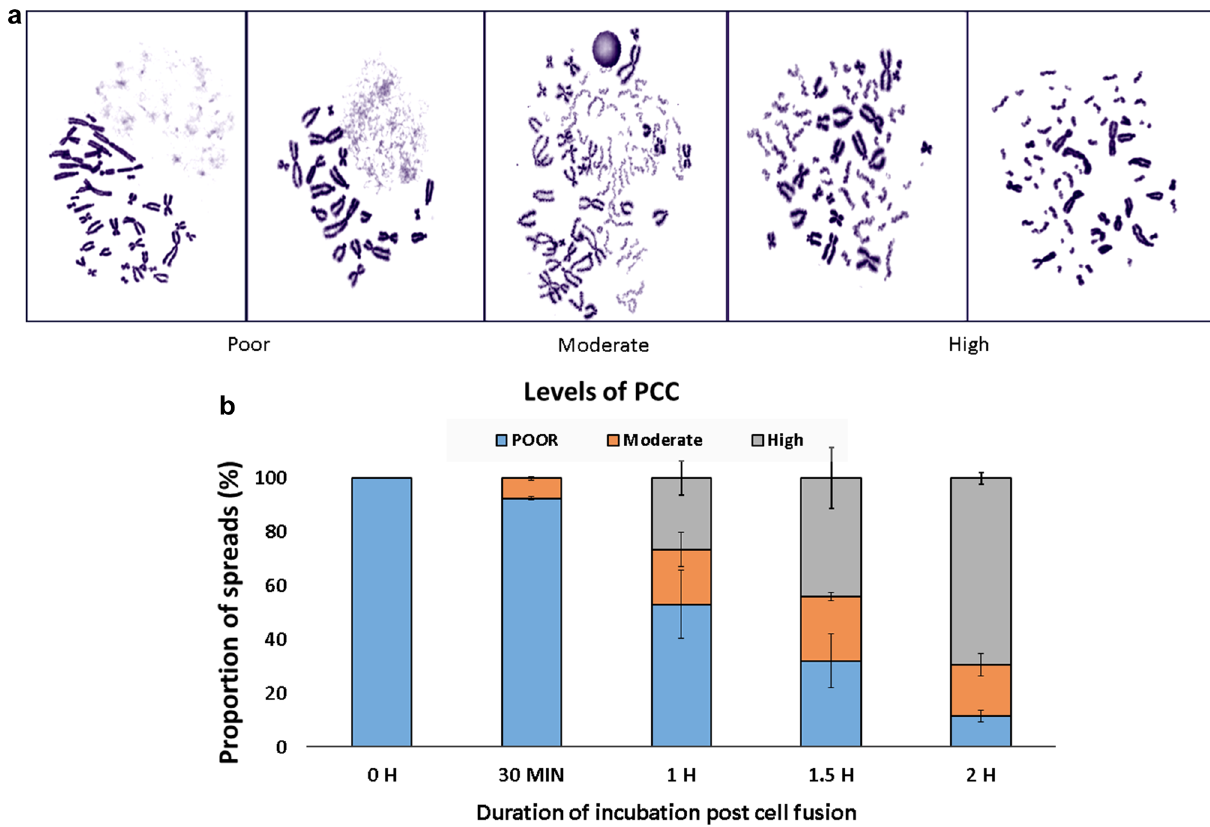
Figure 5. ( a ) Levels of chromosome condensation in PCC from 0 to 2 h after cell fusion. ( b ) Quantification of proportions of poor, moderate and well condensed